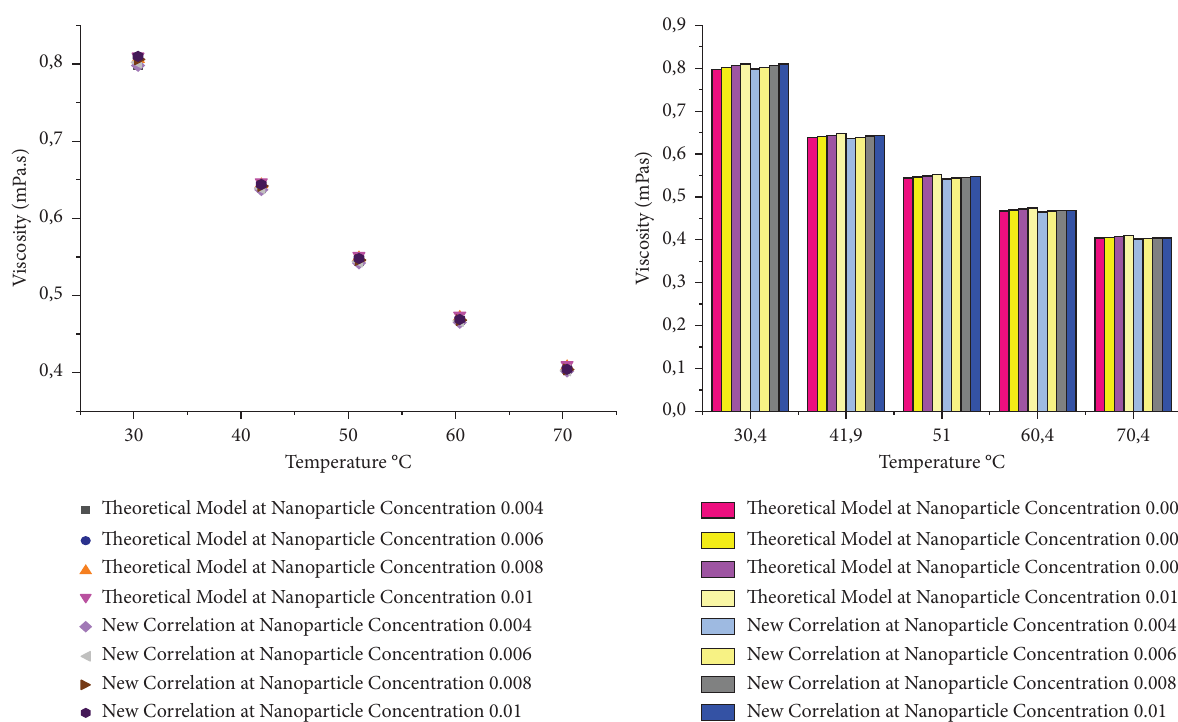
Figure 3: Comparison of titanium oxide-water nanofuid viscosity theoretical model and new correlation.